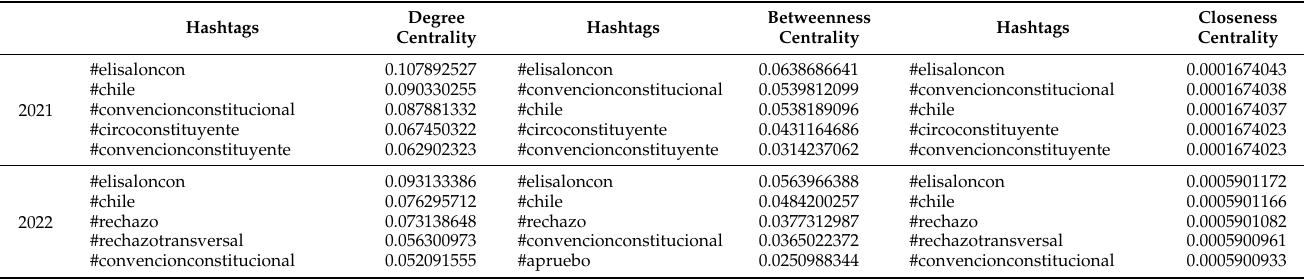
Table 6. Five highest hashtags in local network metrics for “Pueblos Originarios”.